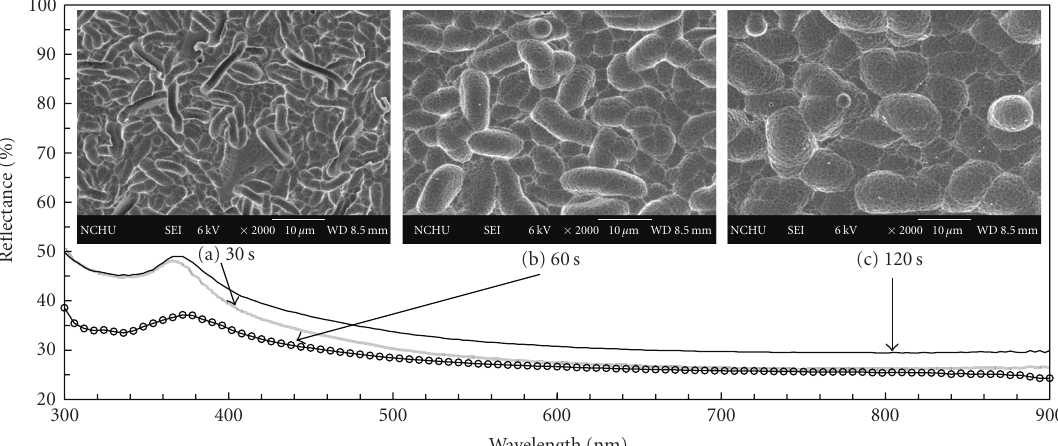
Figure 2: Reflectivity of the textured mc-Si surfaces after 30 seconds, 60 seconds, and 120 seconds of etching in HF : HNO 3 : H 2 O = 15 : 2 . 5 : 1 solution. SEM micrographs of the textured mc-Si surfaces after 30 seconds, 60 seconds, and 120 seconds of etching are shown in inset figure (a), (b), and